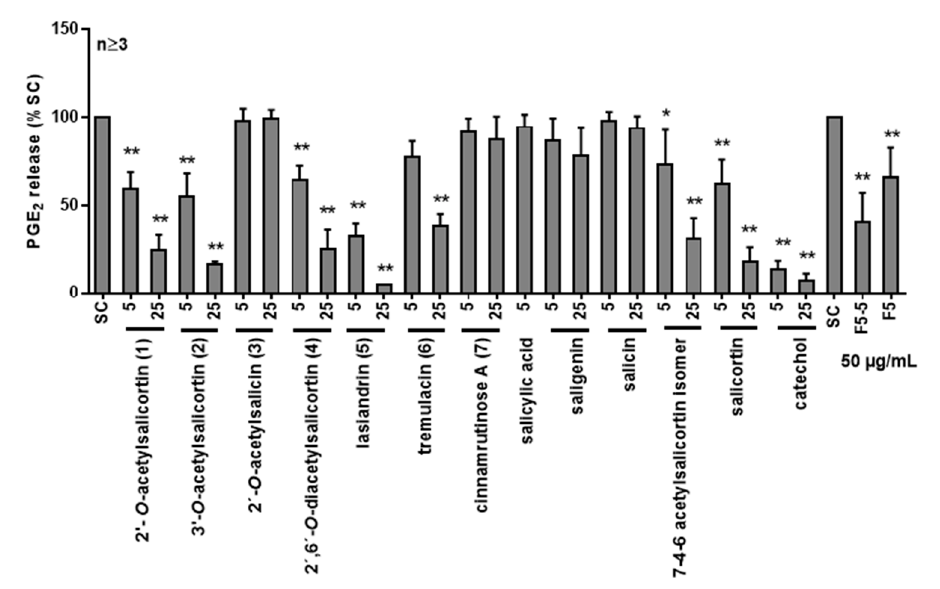
Figure 9. Anti-inflammatory activity of the isolated compounds 1 – 7 and new diastereomeric com- pound of F7-4-6 from S. pentandra methanol extract and the possible degradation/metabolization compounds salicylic acid, saligenin, salicin, salicortin, and catechol. PGE 2 release was quantified in LPS-stimulated PBMC from healthy donors. Cells were stimulated with LPS for 24 h after pretreat- ment with the isolated compounds for 30 min. Data are the means + SD of at least four independent experiments expressed as percentages of the solvent control. Asterisks indicate statistically signifi- cant differences between the respective treatment and the solvent control. * p < 0.05 and ** p < 0.01. SC = solvent control (1% dd water).